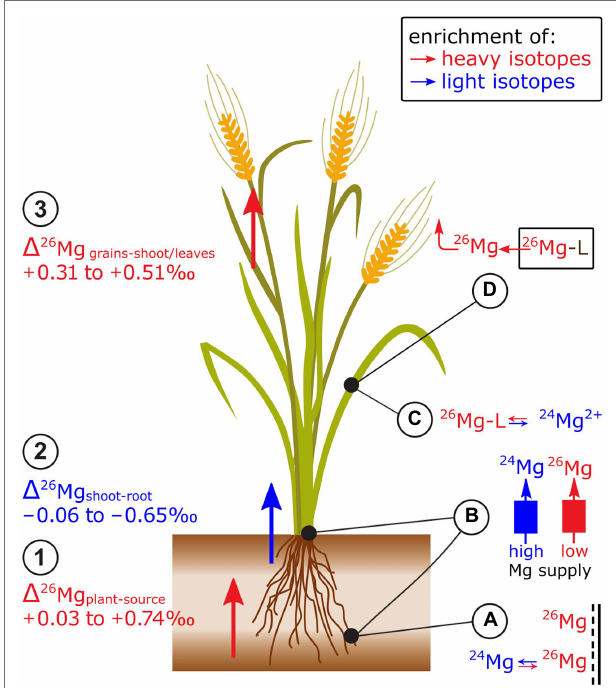
FIGURE 3 | Mg isotope fractionation in plants has been studied in trees and cereals. Exemplified for cereals: (1) Plants are enriched in heavy isotopes compared to the Mg source while (2) shoots tend to be enriched in light isotopes compared to roots. (3) Grains are enriched in heavy isotopes compared to stems and leaves. (A) Heavy Mg isotopes preferentially bind onto negatively charged surfaces in the root apoplast. (B) Binding of Mg to membrane transporters that are active at low Mg supply may induce a shift towards heavy isotopes during plant uptake and root-to-shoot transport compared to Mg transport at regular (or high) Mg supply. (C) It is assumed that the root contains a heavy Mg pool that is bound to organic ligands (Mg- L) while ionic Mg 2+ is enriched in light isotopes that may be preferentially transported toward the shoots. (D) During grain filling, organic ligands that contain Mg degrade (e.g., chlorophyll) and release heavy Mg which may lead to a preferential re-translocation of heavy isotopes from senescent